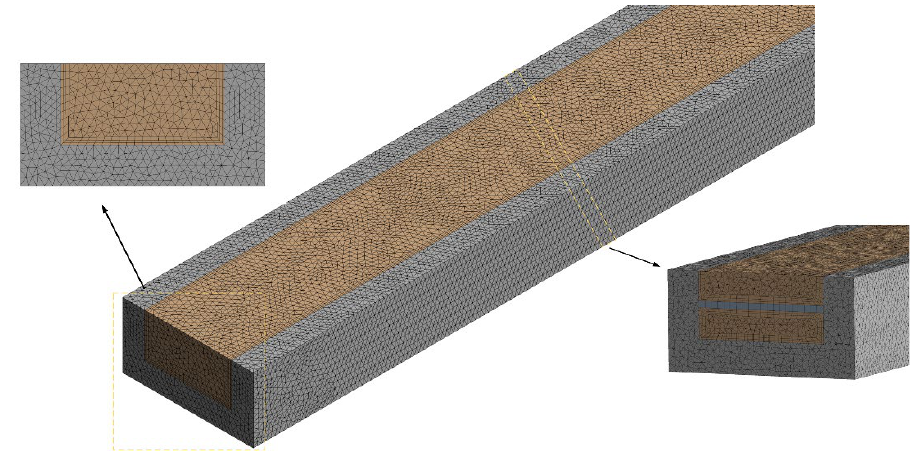
Figure 2. Schematic diagram of grid generation results. Table 2. Grid Verification Data.